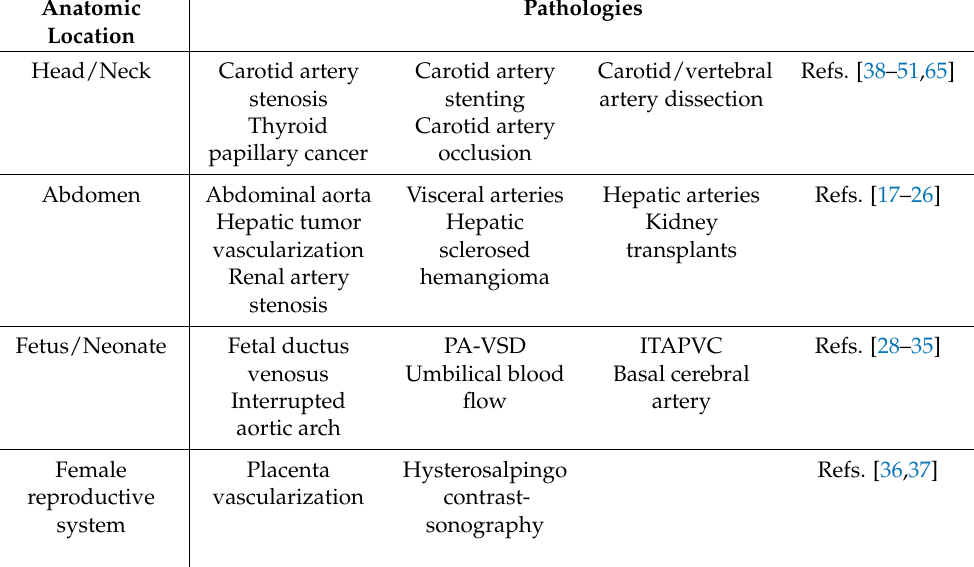
Table 1. Clinical applications of B-Flow ultrasound based on anatomic location. (PA-VSD: pulmonary atresia and ventricular septal defect, ITAPVC: isolated total anomalous pulmonary venous connection, PAOD: peripheral arterial occlusive